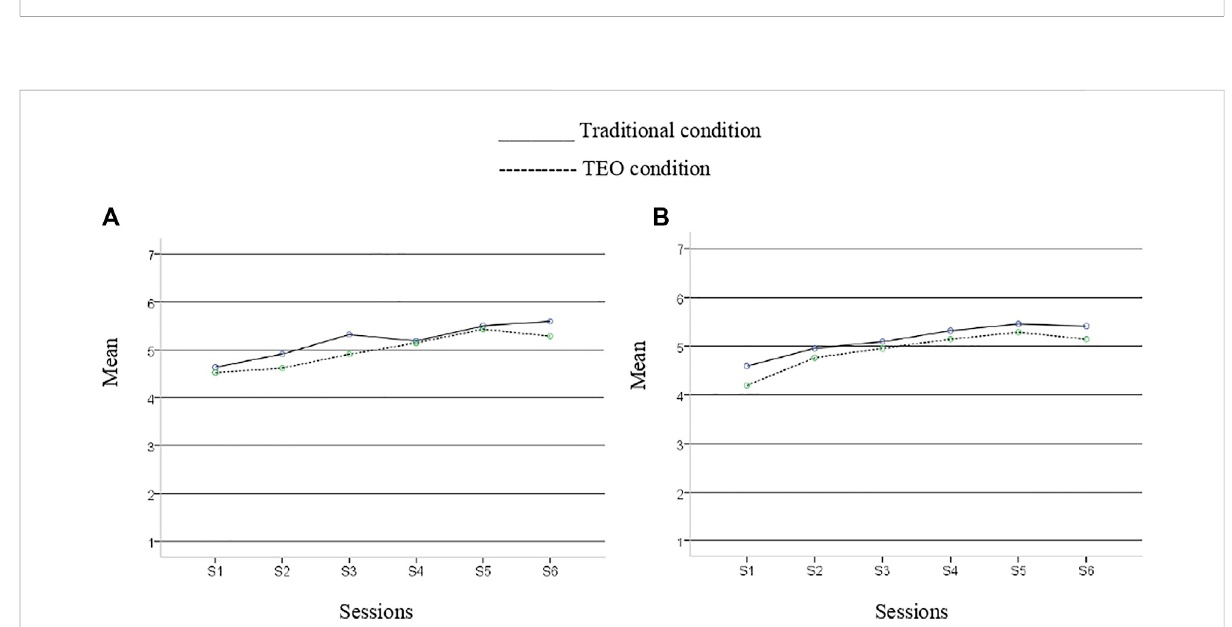
FIGURE 3 Change in mood state (A) and self-ef fi cacy (B) assessed after performing each session.